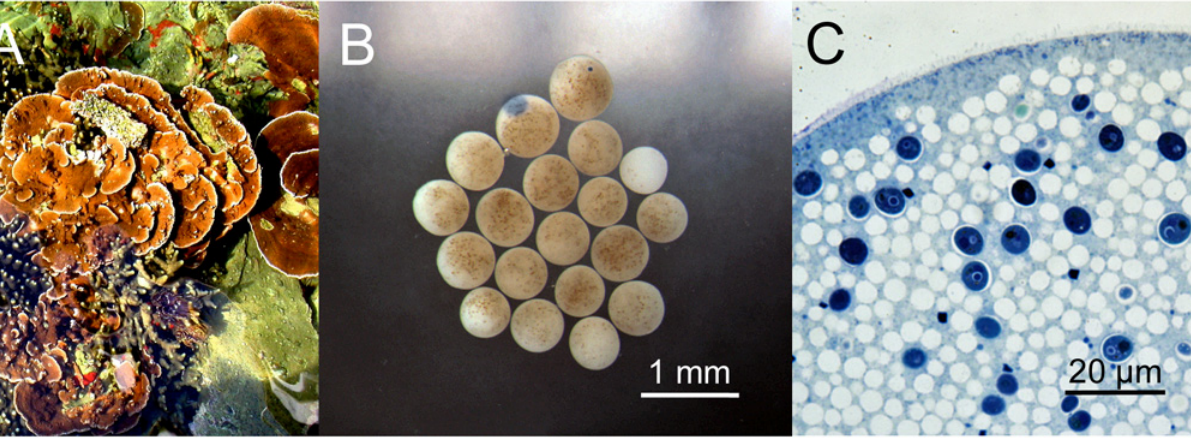
Fig 1. Morphology of M . capitata . ( A) Plate-like adult M . capitata found in Hawaii. (B) Light micrograph of M. capitata eggs demonstrating size and appearance of vertically transmitted intracellular zooxanthellae. (C) Transmission electron micrograph of a single M . capitata egg demonstrating the size and appearance of white yolk droplets and deep blue membrane-bound endogenous